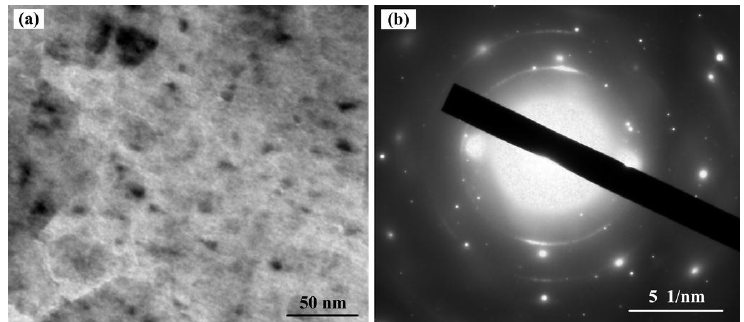
Figure 7. The TEM image of the top surface after HFIR treatment. ( a ) Nanocrystals and ( b ) SAD pattern corresponding to ( a ).